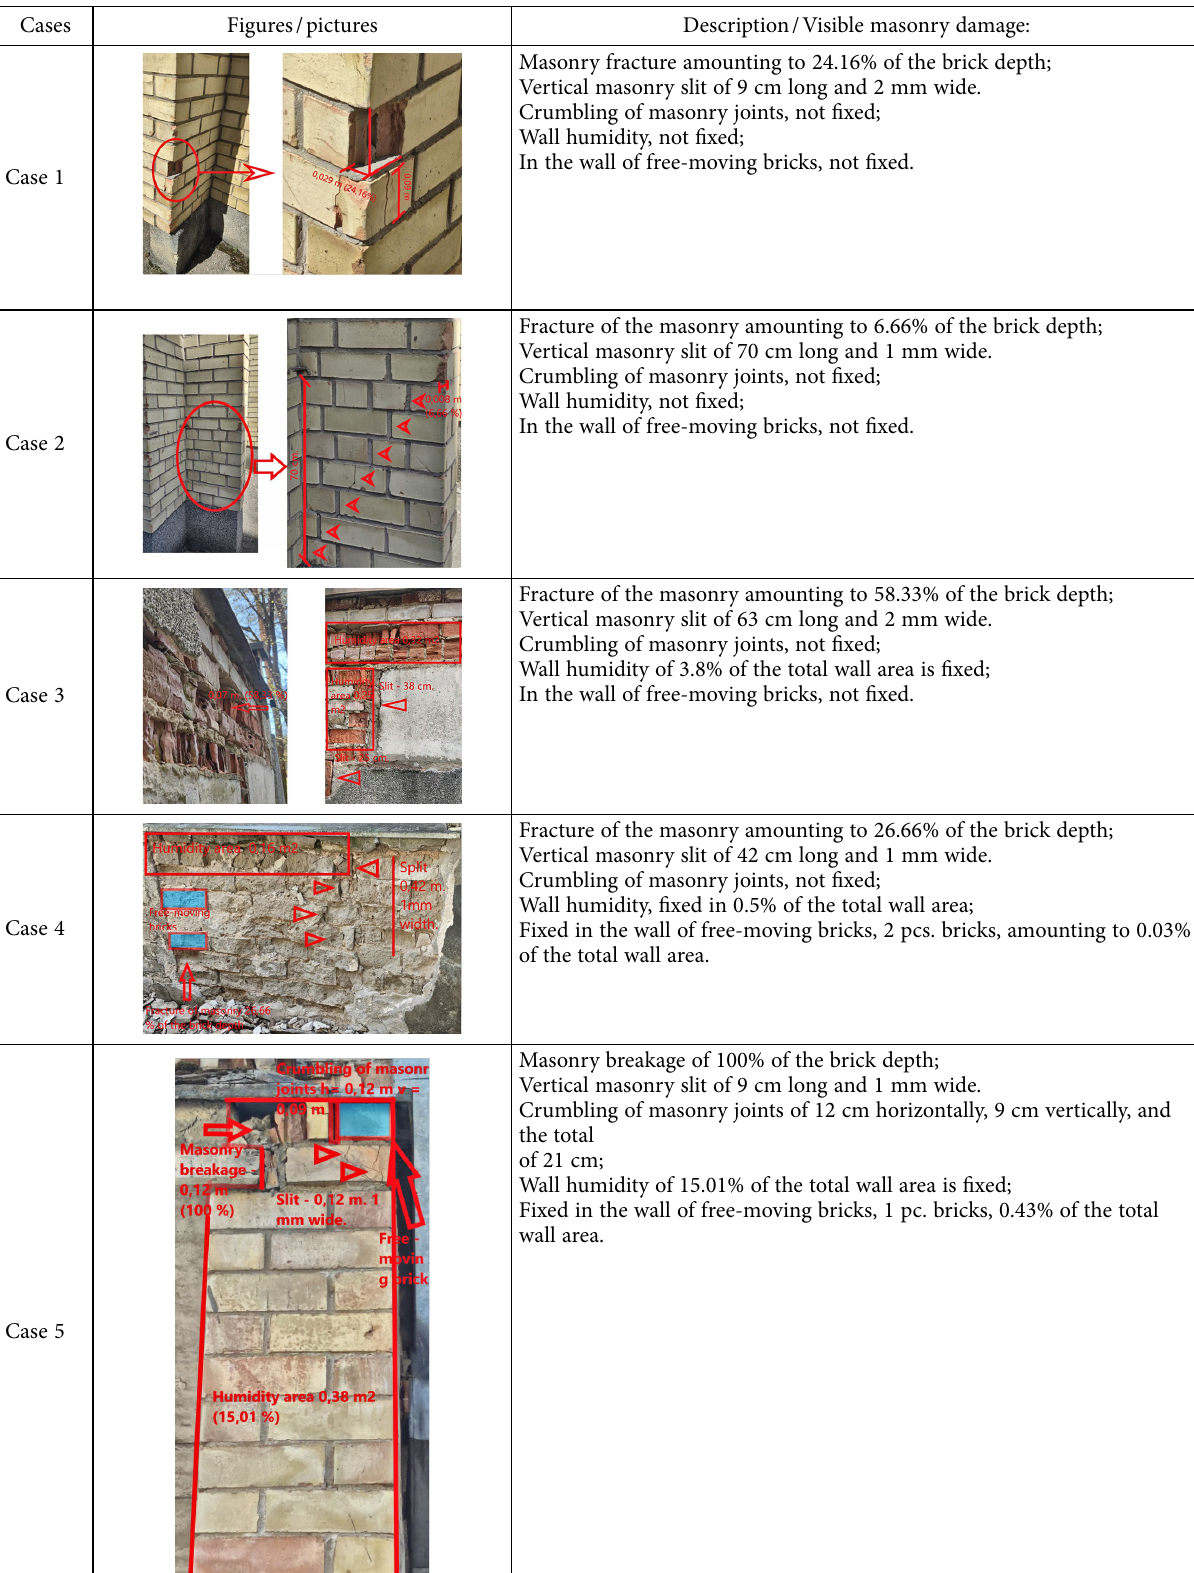
Table 1. Cases of masonry